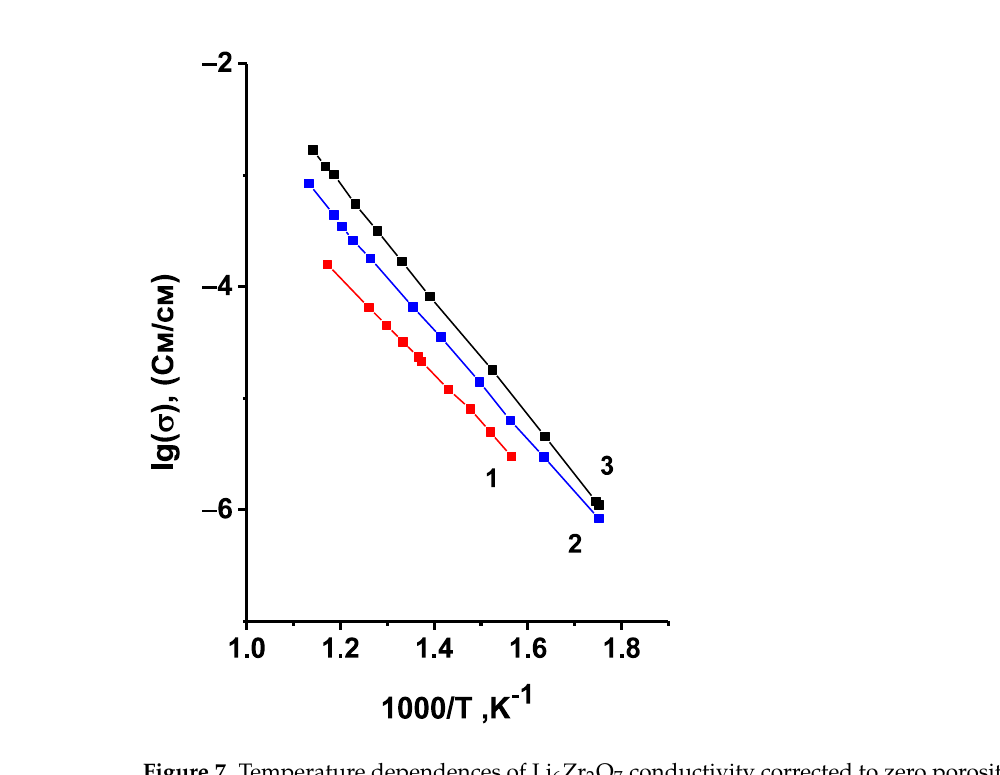
Figure 7. Temperature dependences of Li 6 Zr 2 O 7 conductivity corrected to zero porosity of ceramic samples. The temperature of synthesis and annealing is 850 (1), 900 (2), 950 °C (3).